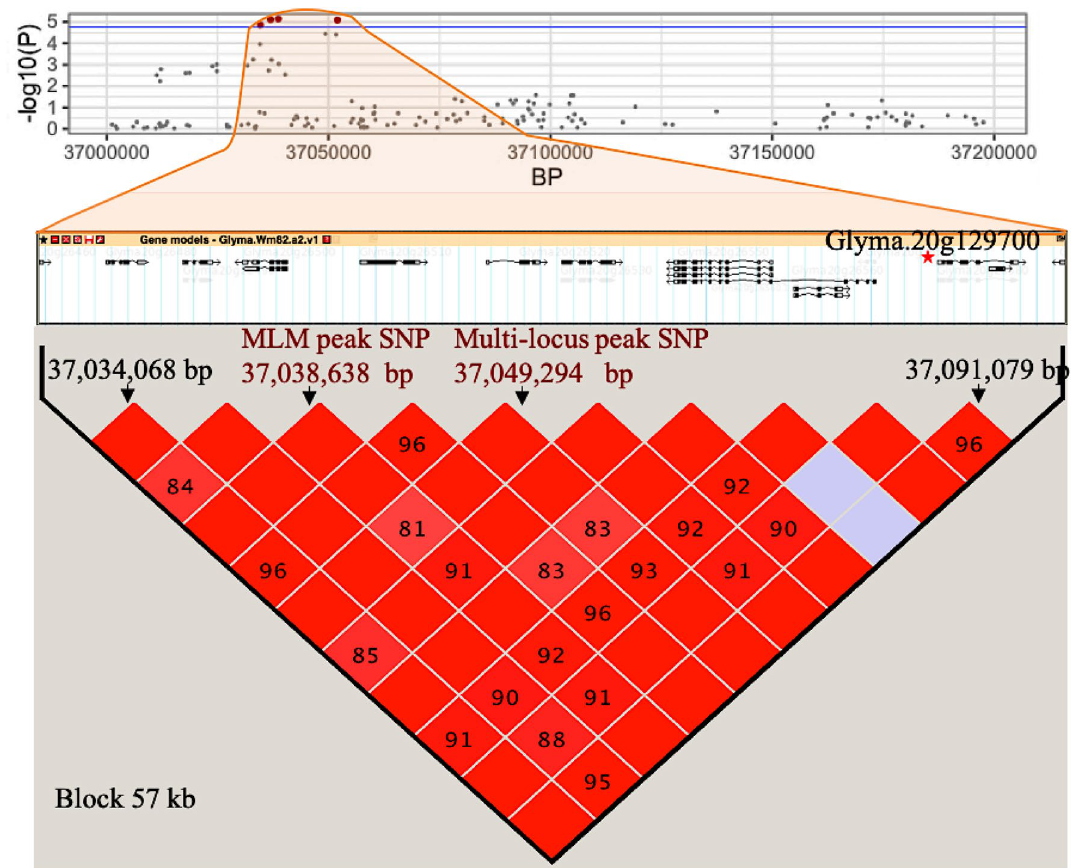
Figure 6. Identification of candidate genes within the haplotype block codetected by both MLM and the multi- locus methods (QTL #9 and QTN #17) on chromosome 20.